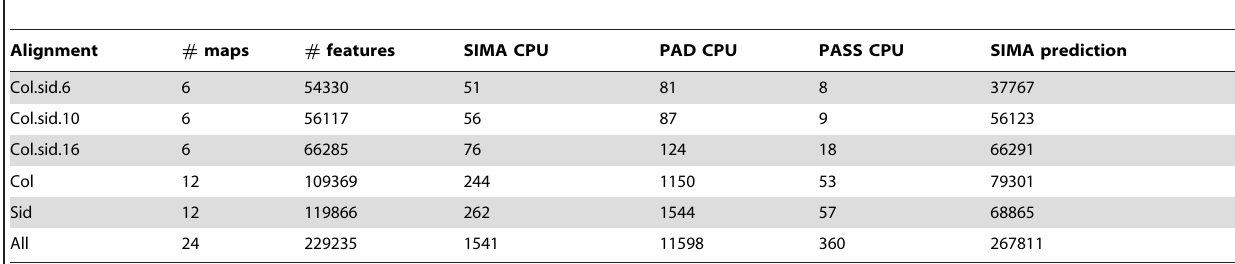
Table 2. Comparison of CPU times for the three algorithms to generate six alignments of the real data representing metabolite changes in Arabidopsis thaliana leaves infected with virulent Pseudomonas syringae .